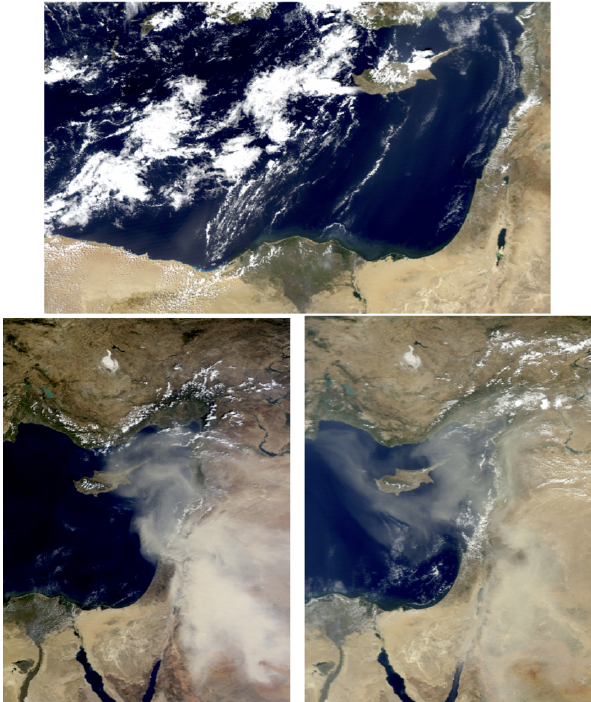
Figure 6. MODIS Aqua true color image (top) for 22 Septem- ber (11:10UTC overpass time) with clouds and dust outflow from Libya to the EM. Bottom: MODIS-Terra true color images: (left) 28 September 2011 (08:55UTC overpass time), (right) 29 Septem- ber 2011 (08:00UTC overpass time) with dust outflow from the Negev and Arabian deserts to the